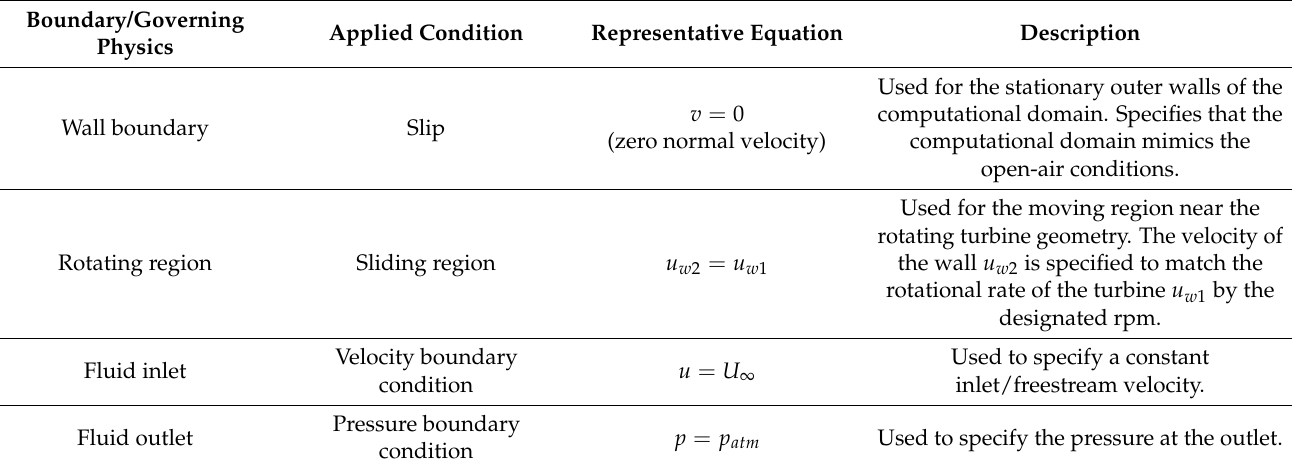
Table 5. Boundary conditions and their descriptions.